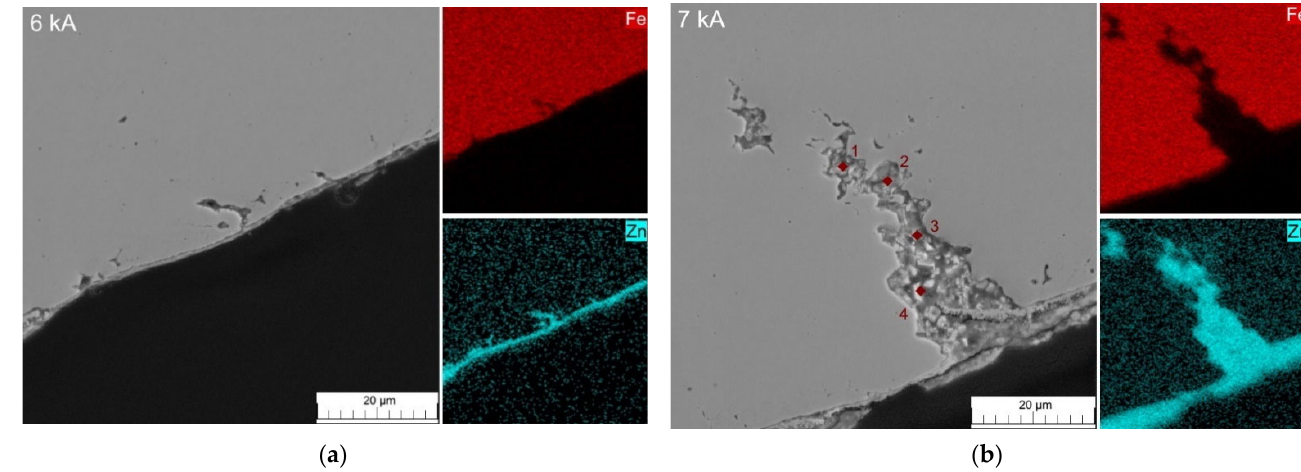
Figure 7. SEM micrographs of the LME cracks combined with the SEM ‐ EDS element distribution maps: ( a ) 6 kA, ( b ) 7 kA. Table 5. Results of SEM ‐ EDS chemical point analysis (in wt. %) of the inner part of the LME cracks.